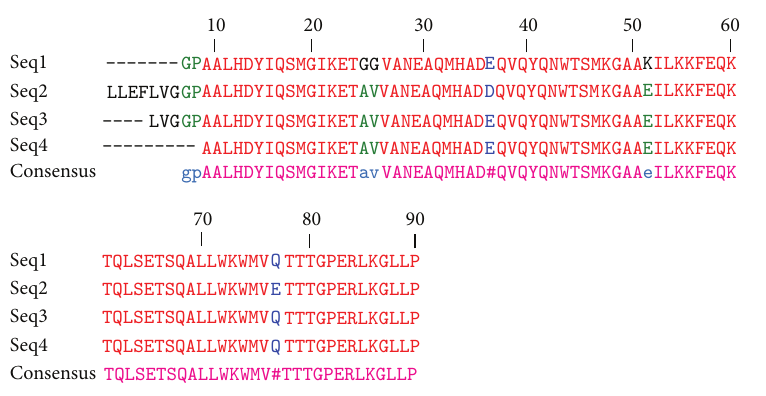
Figure 1: Multiple sequence alignment (seq1 related to Milad hospital and seq2, seq3, and seq4 related to Loghman Hakim hospital).